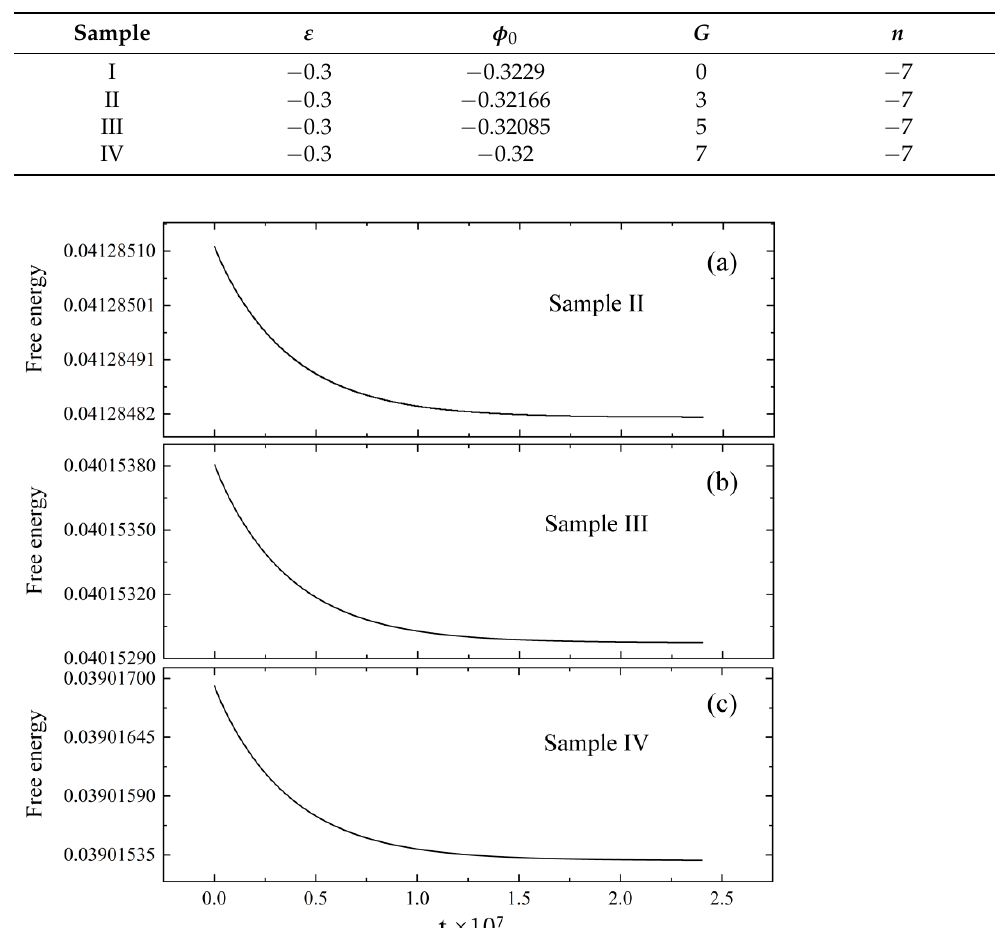
Table 1. Detailed parameters for the solidifications under zero-gravity (sample I) and supergravity (sample II–IV) fields.